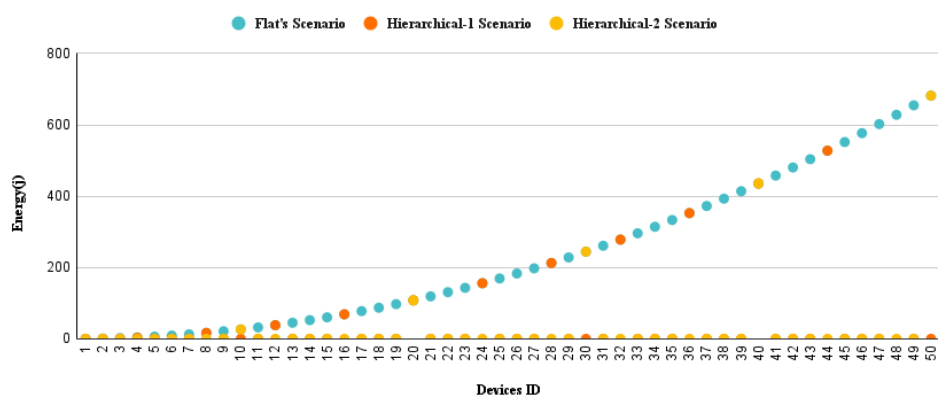
Figure 9. Energy consumption for different topologies.